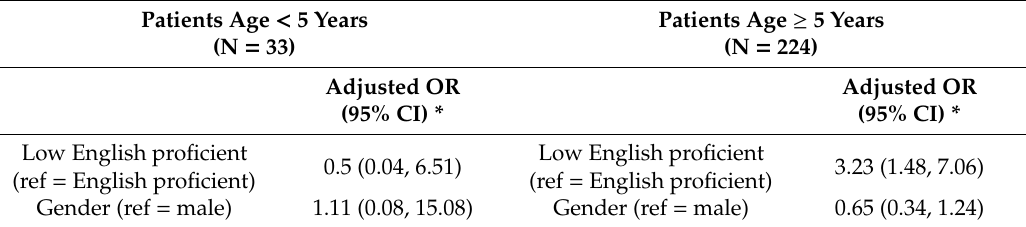
Table 5. Subgroup analysis of no PACU pain assessment by